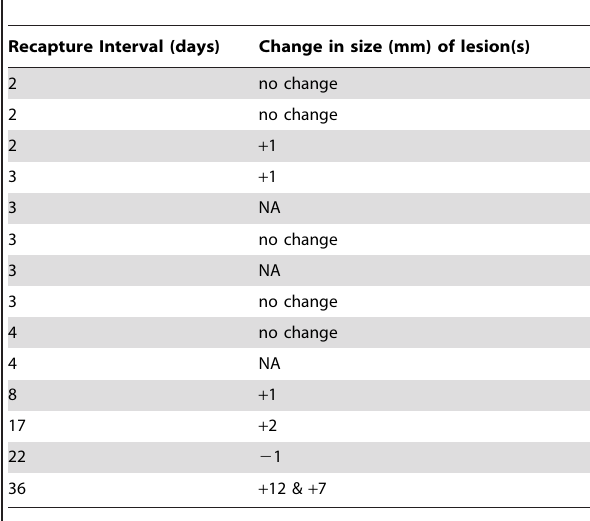
Table 3. Details of birds captured twice with pox lesions.